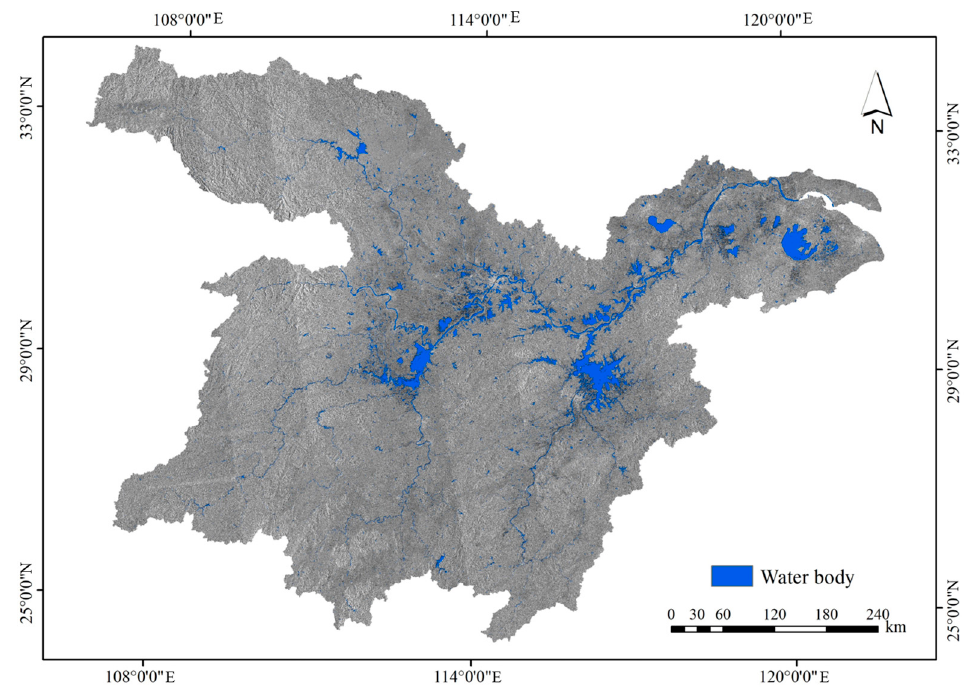
Figure 8. Detailed map after post-processing showing the mosaic results of water body from 10 July